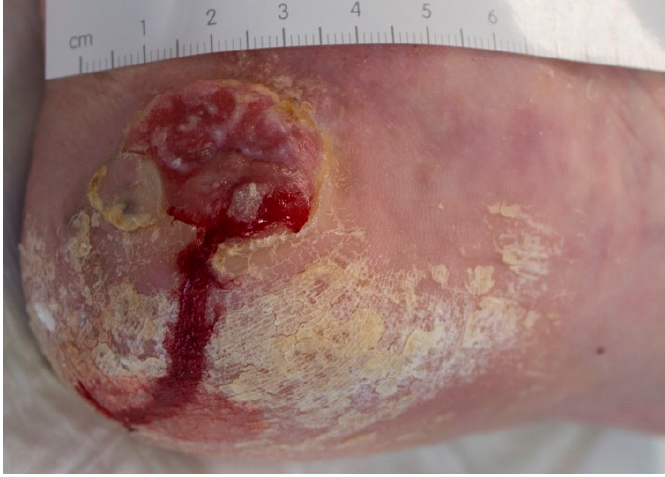
Figure 3. Example of a MM on the heel, initially misdiagnosed and treated as traumatic wound.